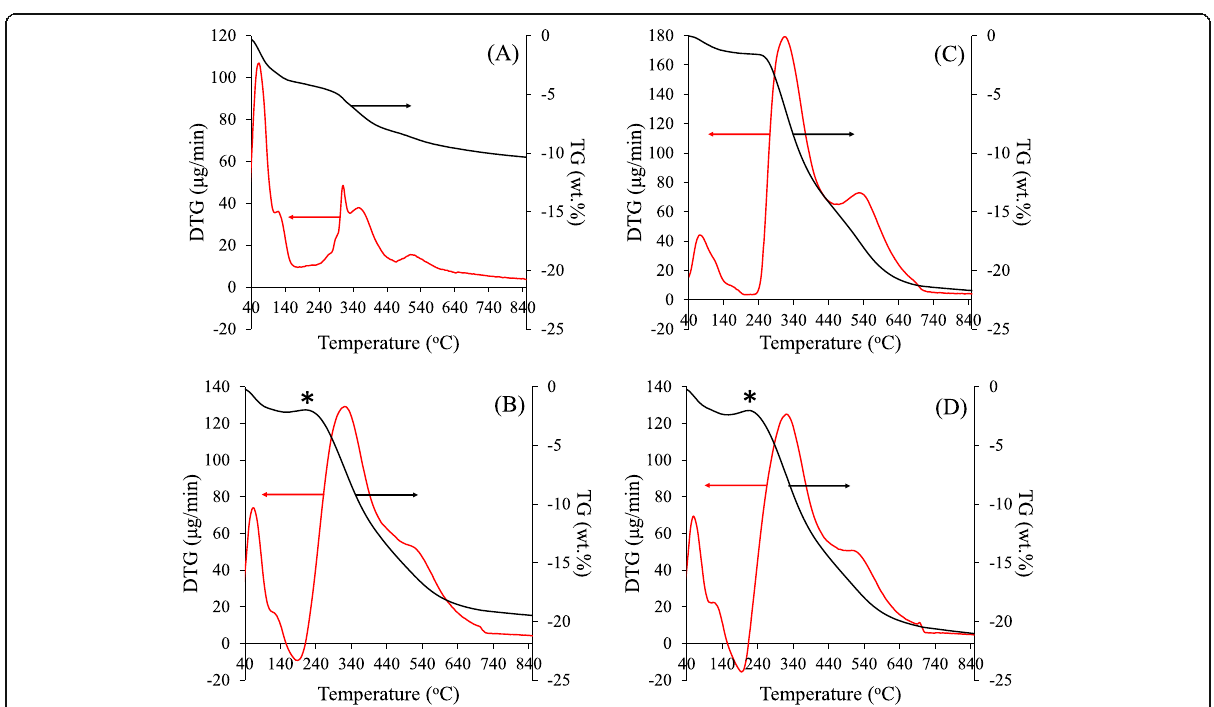
Fig. 1 Representative TG and DTG curves of ( a ) HMS, ( b ) NRHMS, ( c ) NRHMS(2.5), and ( d ) NRHMS(10). Asterisk represents the step at which the NR was auto-oxidized